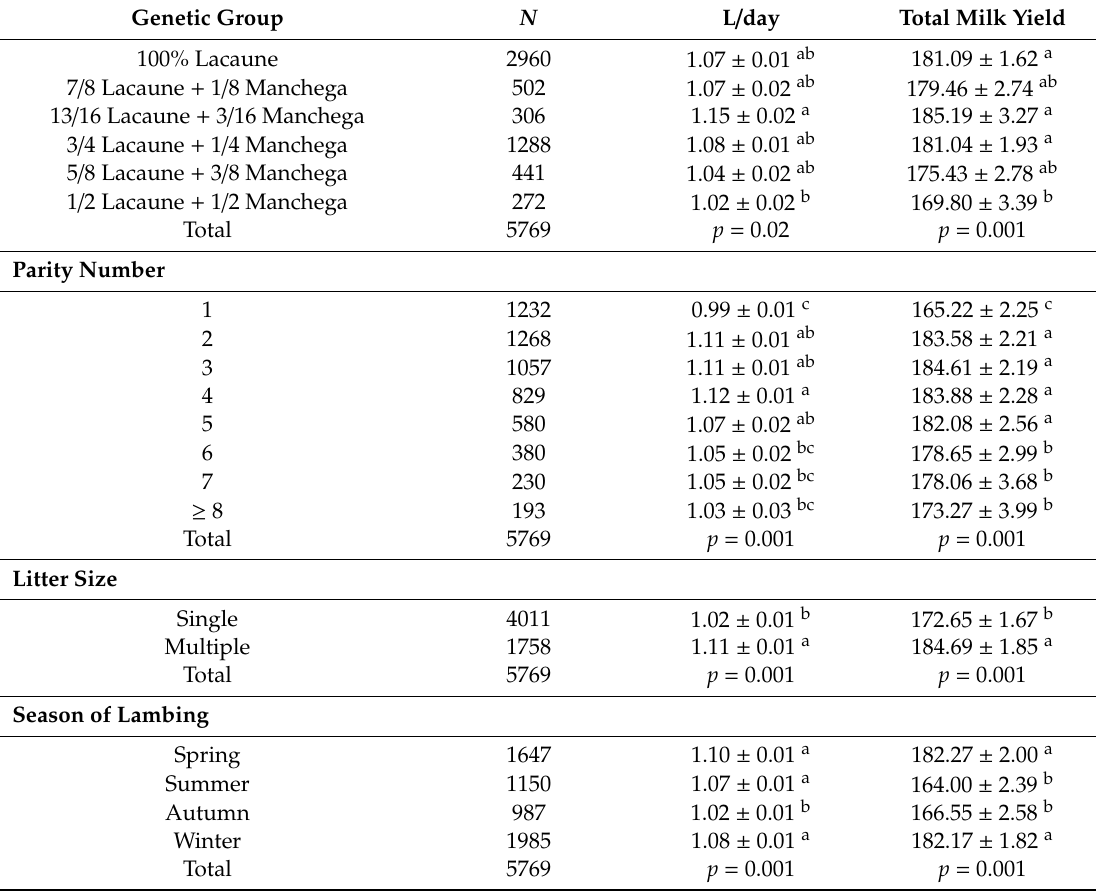
abc Di ff erent letters in the same column are di ff erent statistically ( p < 0.001). Parity number, due to some animals lambing more than once a year, some animals have more parity records; additional parities above 8 were grouped as ≥ 8.